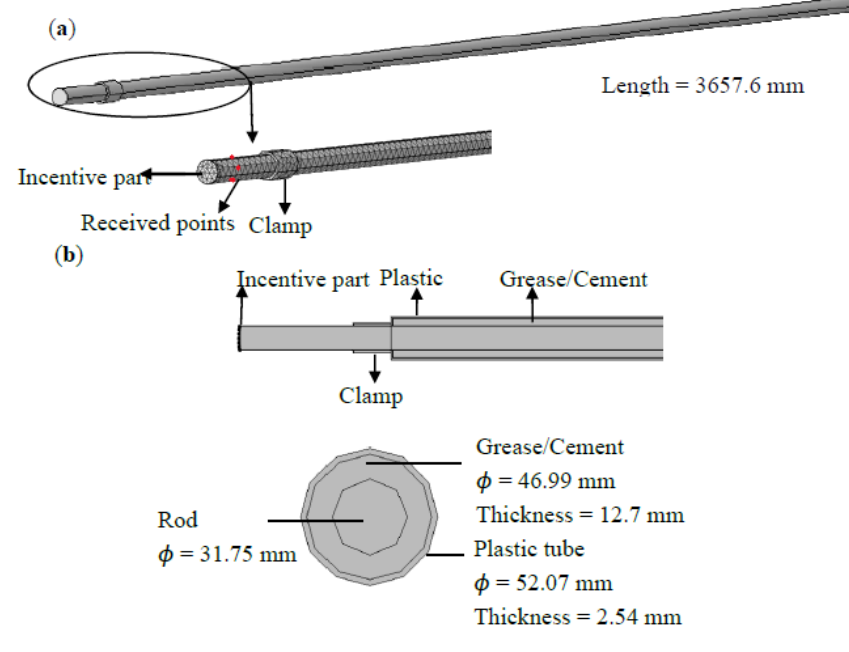
Figure 3. Rod models.